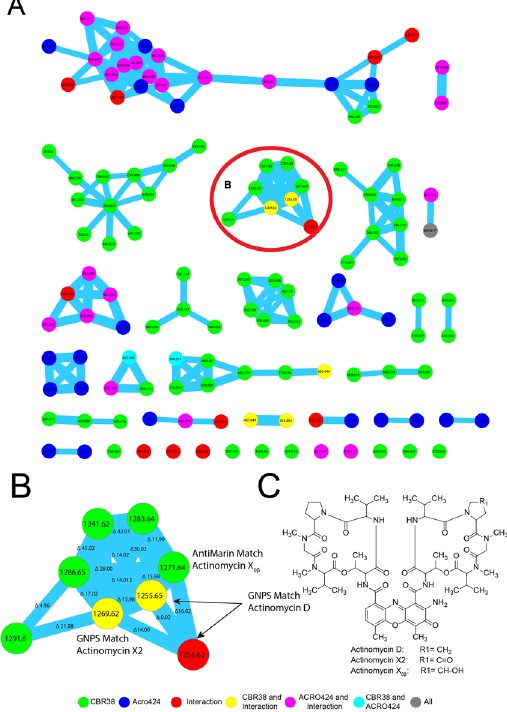
Figure 4. Molecular network from Streptomyces CBR38 and Escovopsis Acro424 with the identification of the actinomycins. ( A ) Molecular network after filter blank, colors indicate producers of the nodes: Streptomyces CBR38 green; Escvopsis ACRO424 blue, Streptomyces sp. vs Escovopsis sp (CBR38 vs ACRO424) red. Nodes found in more than one producers are represented as combination of their colors: Streptomyces CBR38, Streptomyces sp. vs Escovopsis CBR38 vs ACRO424 yellow; Escvopsis ACRO424, Streptomyces sp. vs Escovopsis sp (CBR38 vs ACRO424) pink; Streptomyces CBR38, Escvopsis ACRO424 cian. ( B ) Enlarged cluster of actinomycin D, actinomycin X2 and actinomycin X 0 β . ( C ) Chemical structures of actinomycin D, actinomycin X2 and actinomycin X 0 β